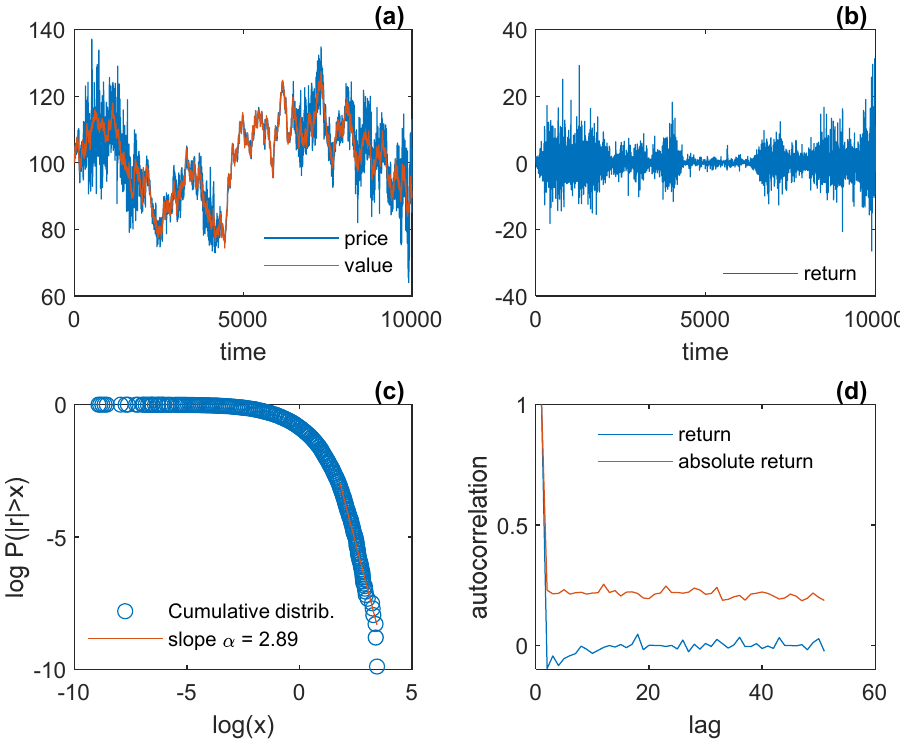
Figure 3. A purely news-driven market model: ( a ) price and value; ( b ) return; ( c ) tail; ( d ) autocorrelation function of return and absolute return.